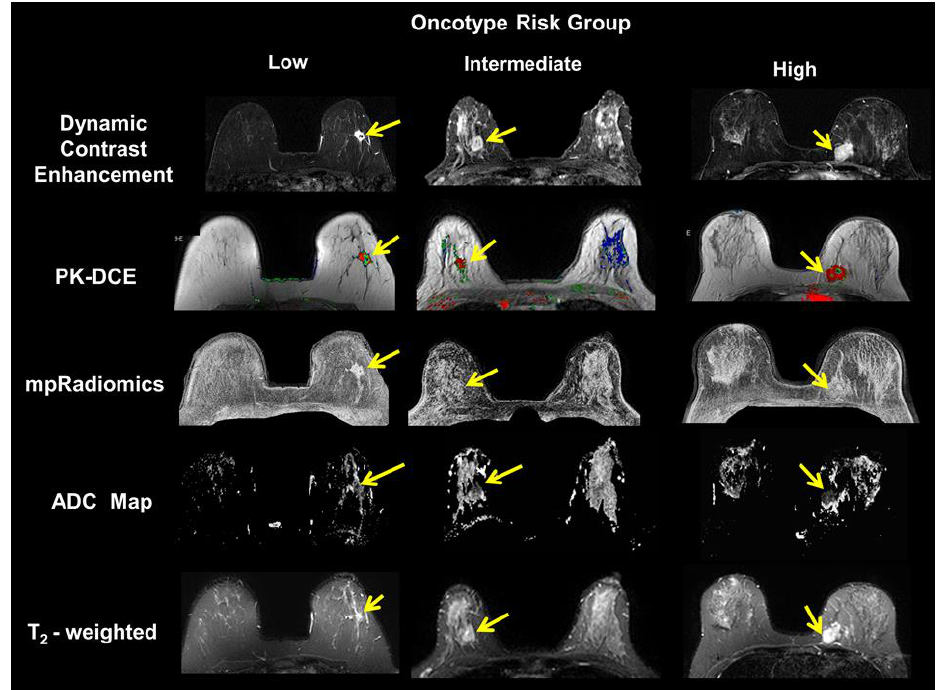
Figure 2 . Demonstration of multiparametric magnetic resonance imaging (MRI) breast imaging of each risk group defined by the OncotypeDX. ( Left Column) typical imaging of the low risk patient. ( Middle Column) typical imaging of the medium risk patient. ( Right Column) typical imaging of a high-risk patient. The yellow arrows indicate the primary lesion in the breast. The MRI images of T 2 -weighted (T 2 ), apparent diffusion coefficient (ADC) map, Pharmacokinetic Dynamic Contrast Enhanced (PK-DCE) and multiparametric radiomics demonstrate the different malignant lesions.